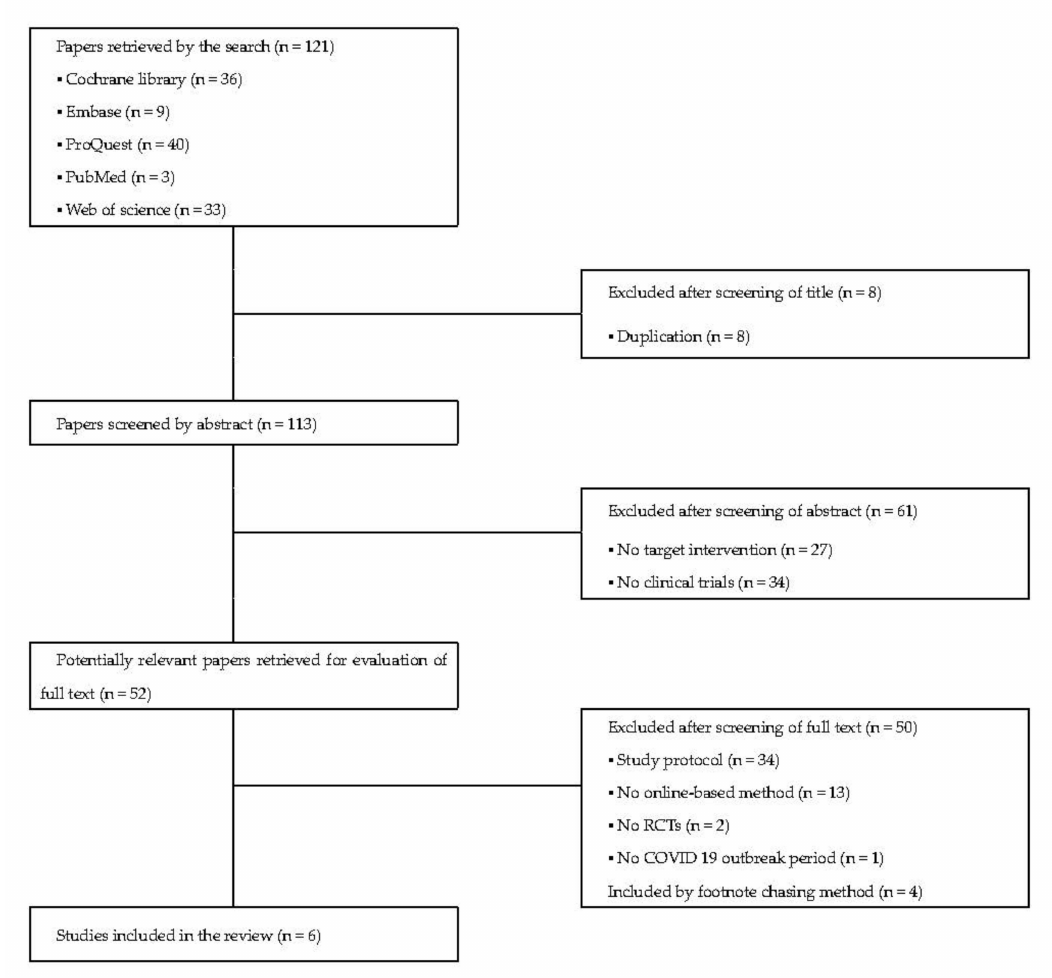
Figure 1. Flowchart of included studies through the literature